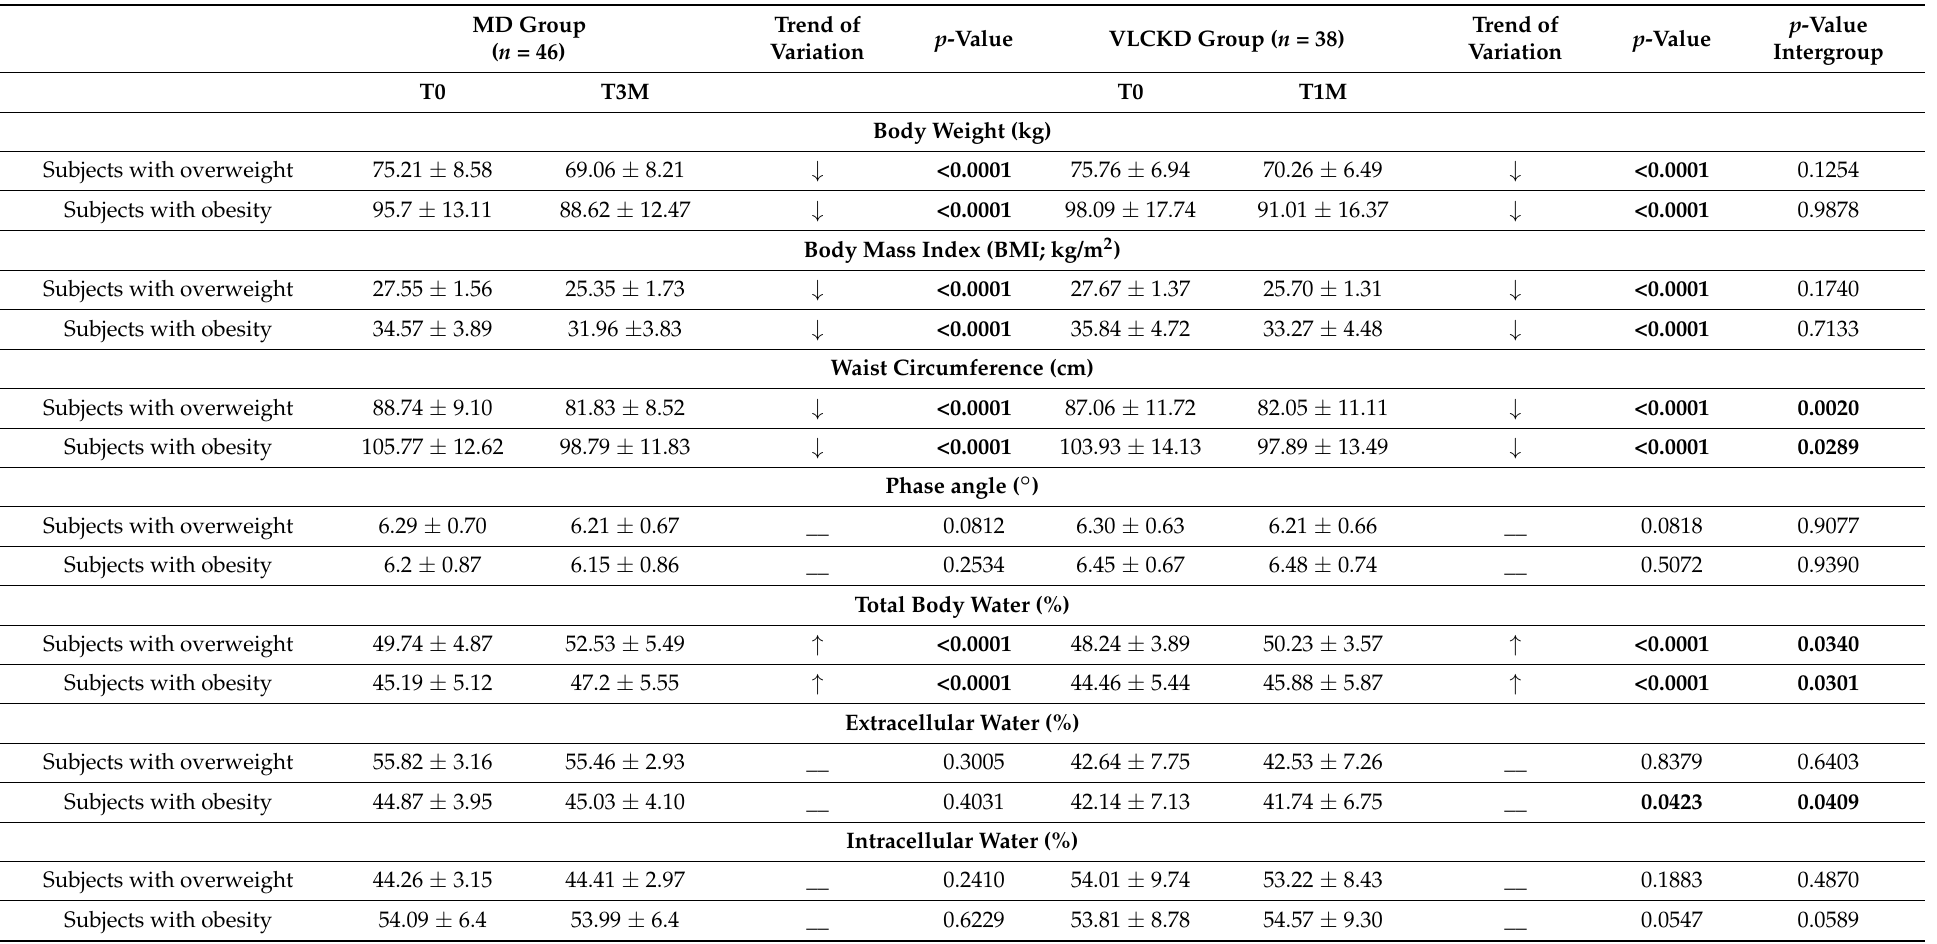
Table 3. Anthropometric and body composition changes in MD and VLCKD groups according to BMI (mean ±